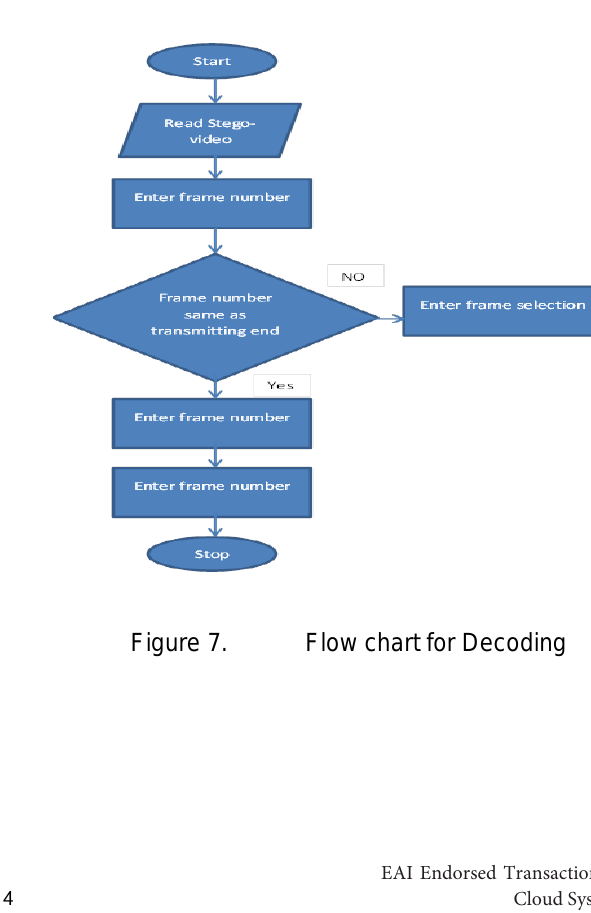
Figure 7. Flow chart for